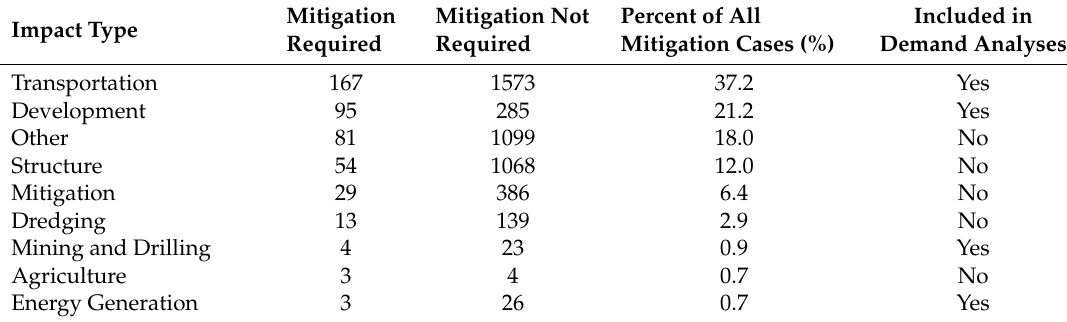
Table 7. Generalized impact type frequencies by mitigation